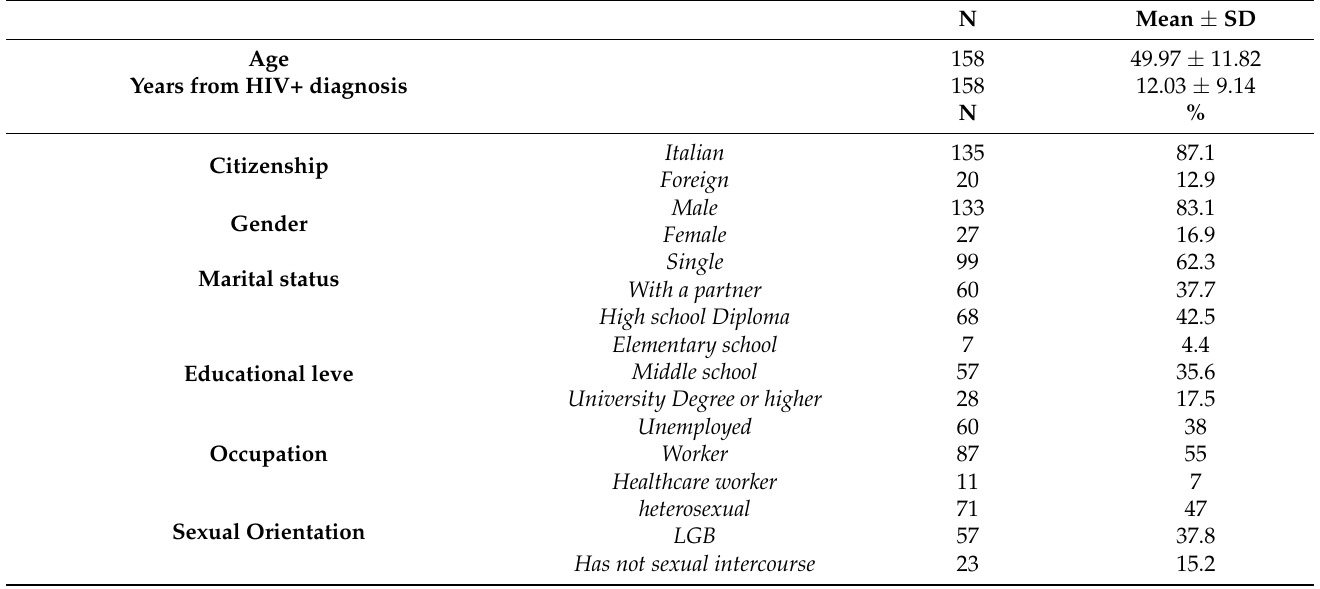
Table 1. Sample’s description (N =